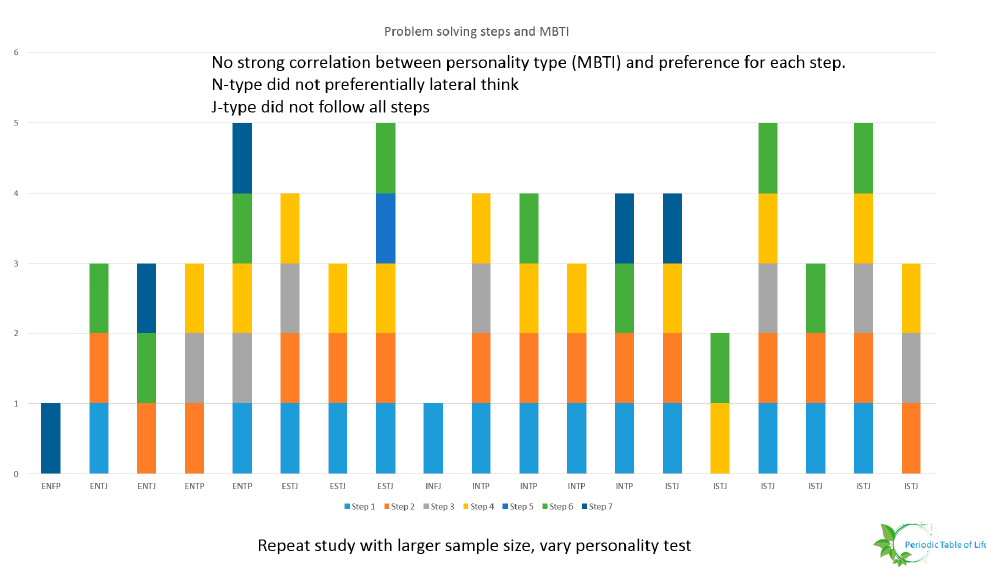
Figure 36. Proportion of population that uses problem solving steps.